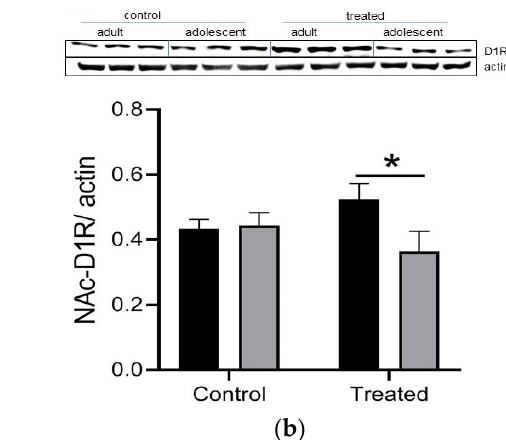
Figure 3. CPP induced by a single amphetamine conditioning in adolescent and adult C57BL/6J mice with prior nicotine and alcohol experience. Male and female mice of the two age groups ( n = 7–8 mice per sex and age group) were tested for baseline and then received six conditioning with saline or nicotine (0.25 mg/kg, s.c.), followed by six conditioning with ethanol (2 g/kg, i.p.) in the nicotine-paired chamber and saline in the saline-paired chamber. Mice were then conditioned with saline or amphetamine (3 mg/kg, i.p.) once daily in a counterbalanced manner and then tested for CPP 24 h after the last conditioning. Amphetamine conditioning was carried out in the nicotine-alcohol-paired chamber. Data represent the amount of time that mice spent in the drug-paired chamber (DPCh) or vehicle-paired chamber (VPCh) on the baseline test day (D1), CPP test day under a drug-free state (D20), and drugged state (D21) and analyzed by three-way ANOVA followed by the Fisher LSD test. ** p < 0.01 versus its respective VPCh **** p < 0.0001 versus their respective VPCh; ++++ p < 0.0001 versus DPCh in Adolescents.